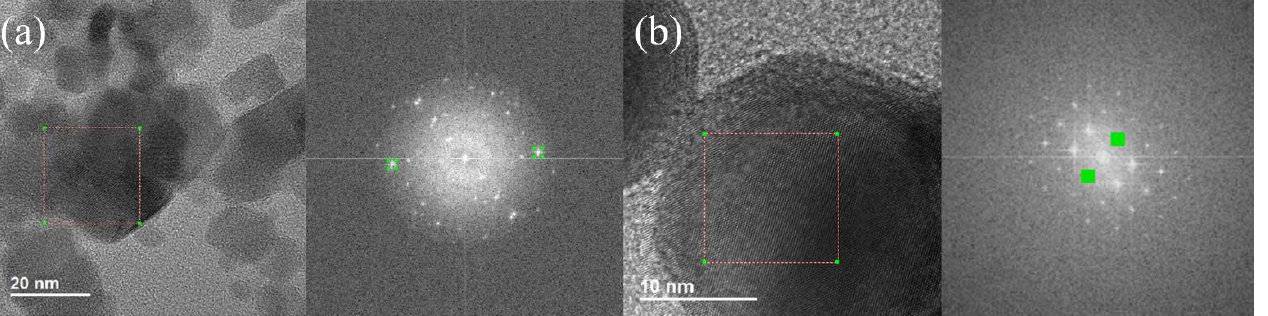
Figure 4. TEM images with selected area for FFT denoted by the red dashed box and the correspond- ing diffraction patterns of ( a ) MNPs and ( b ) MAuNPs.